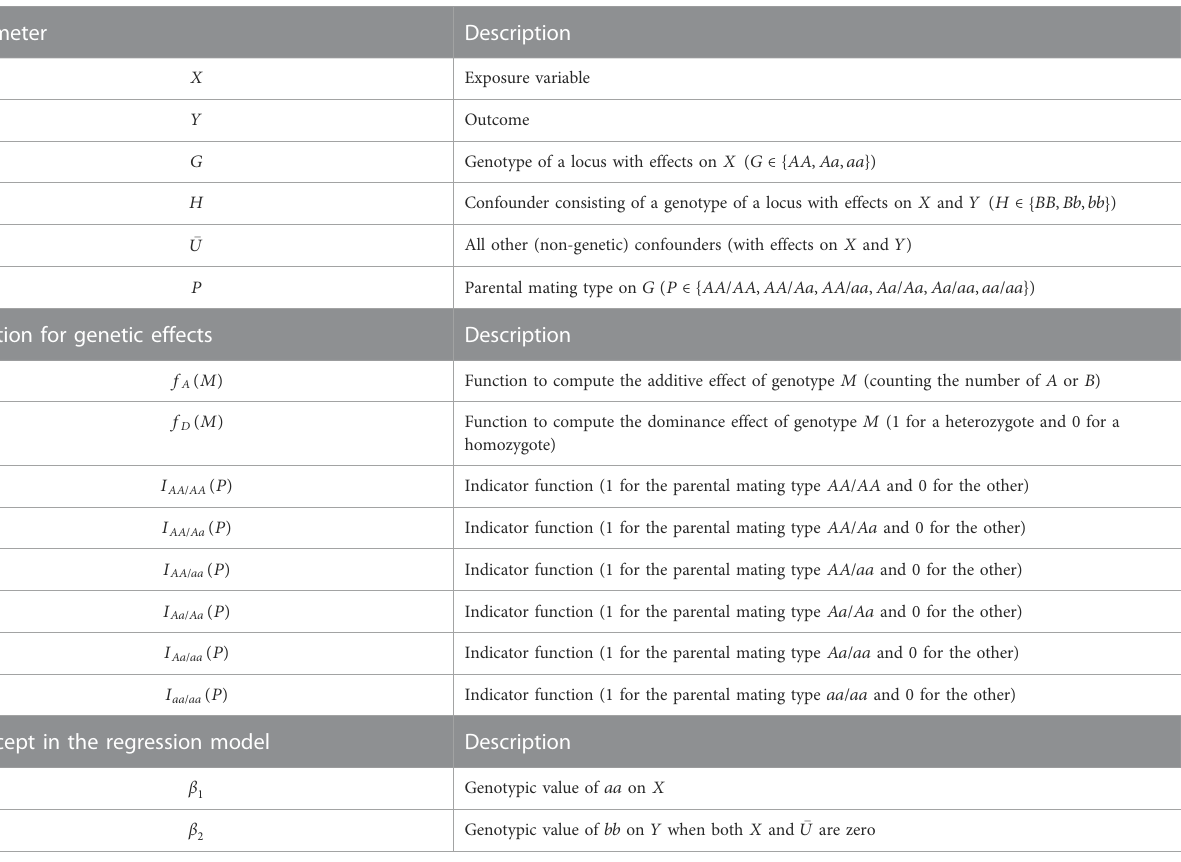
TABLE 1 Summary of variables, functions, and intercepts in regression models.